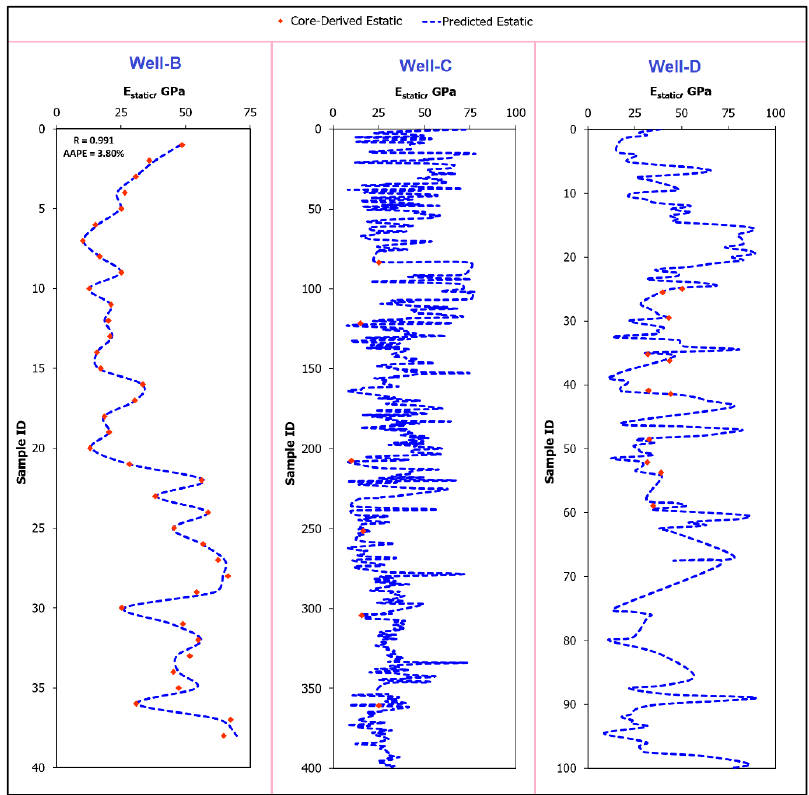
Figure 7. Plot of the predicted and the core-derived E static for the validation datasets collected from Well-B, Well-C, and Well-D.